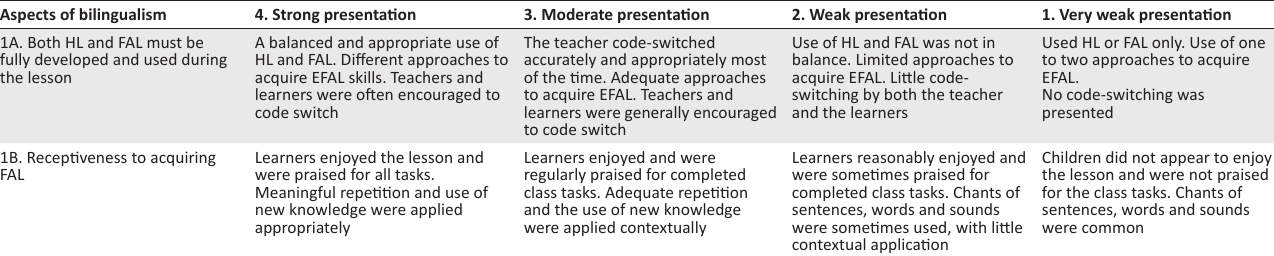
TABLE 2: A sample of criteria used for coding the lessons. Aspects of bilingualism